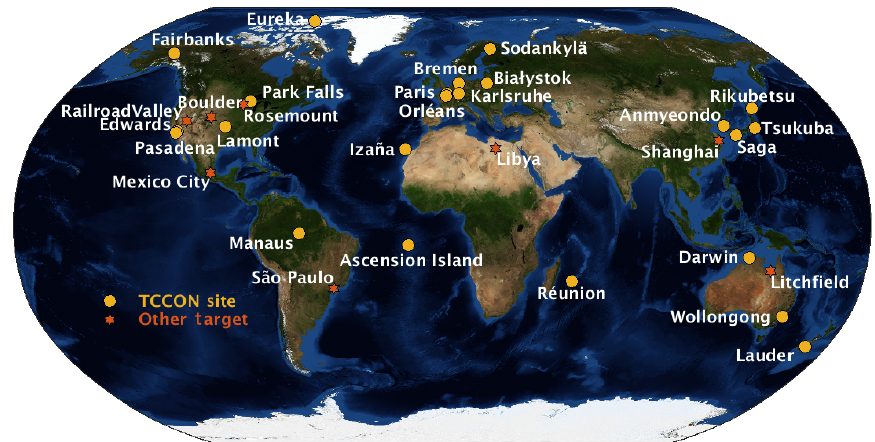
Figure 3. Map of OCO-2 target locations. Yellow circles show the locations of the targets that coincide with TCCON stations; orange stars show the locations of targets that do not have co-located TCCON